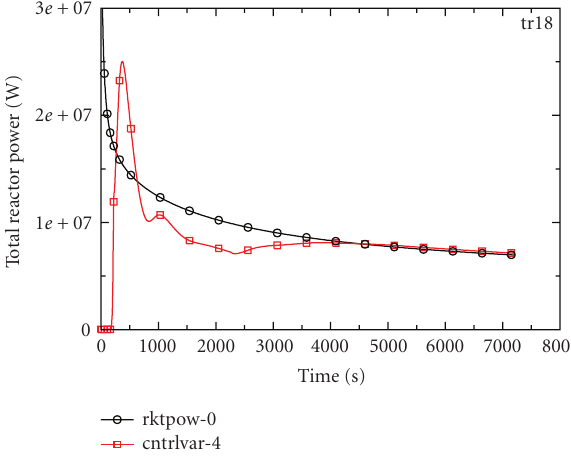
Figure 4: Reactor power and power removed by in-vessel emer- gency heat